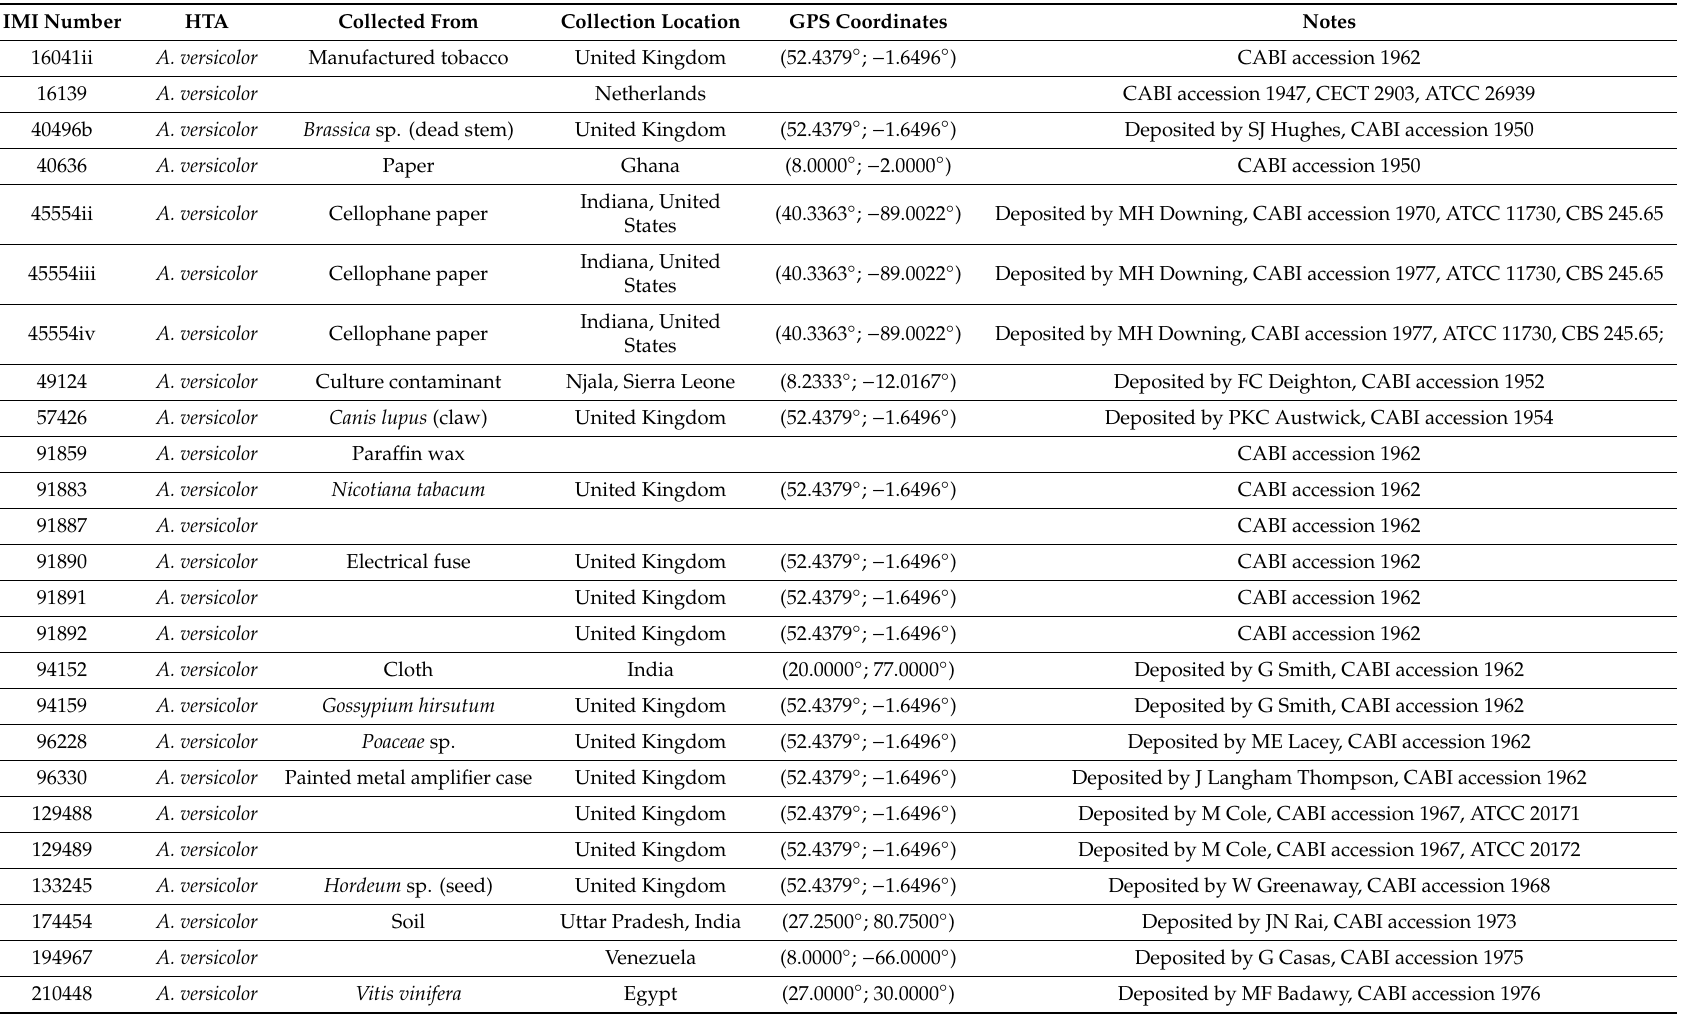
Table 1. Strains used in the current